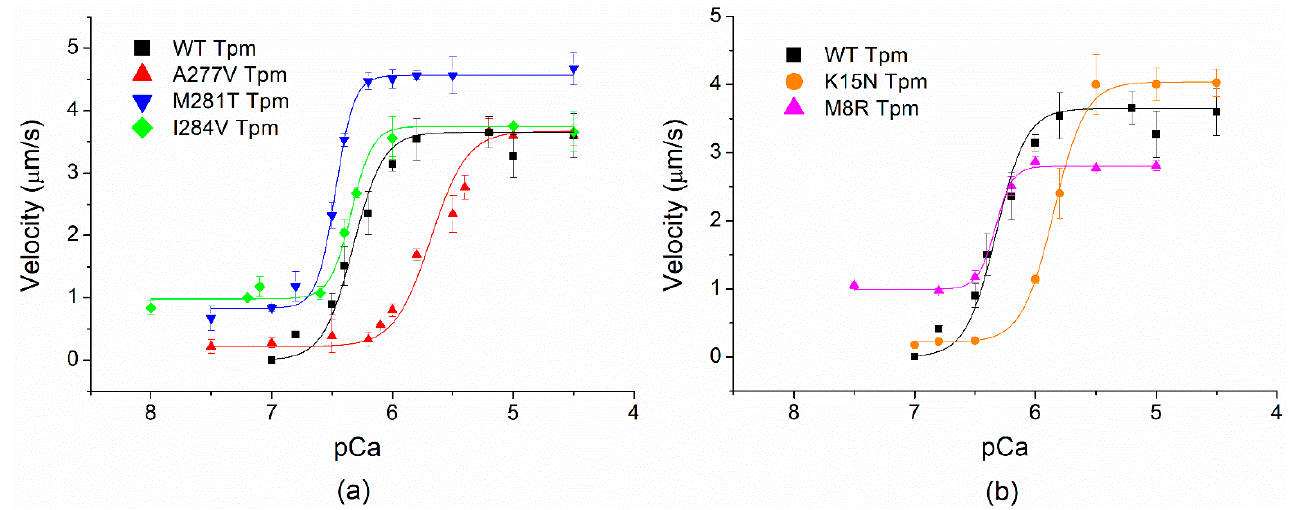
Figure 6. Effects of Tpm cardiomyopathy-causing mutants on Ca 2+ -dependent sliding velocity of regulated thin filaments. ( a ) Effects of the C-terminal mutants A277V, M281T, and I284V; ( b ) effects of the N-terminal mutants M8R and K15N. Each data point is the mean ± SD from three experiments. The data were fitted to the Hill equation. The pCa 50 values at which the sliding velocity was half-maximal are shown in Table 3. Table 3. Effects of Tpm mutations on the characteristics of the pCa-velocity